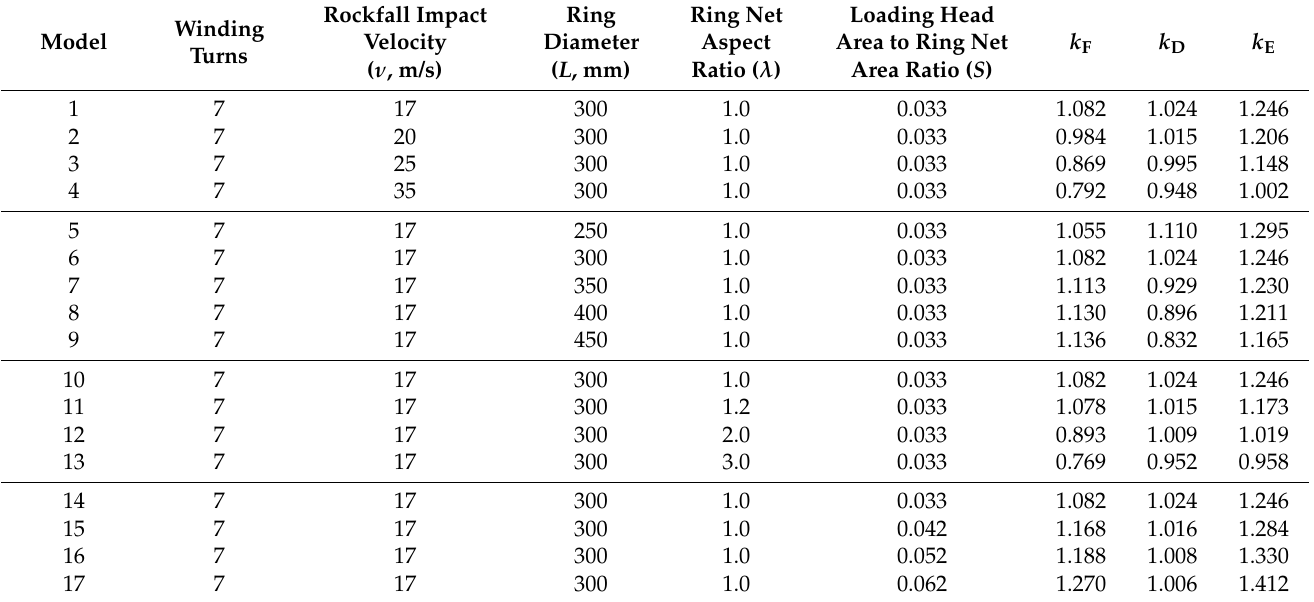
Table 8. Corresponding k F , k D , and k E values under different rockfall impact velocities, ring diameters, ring net aspect areas, and loading head area to ring net